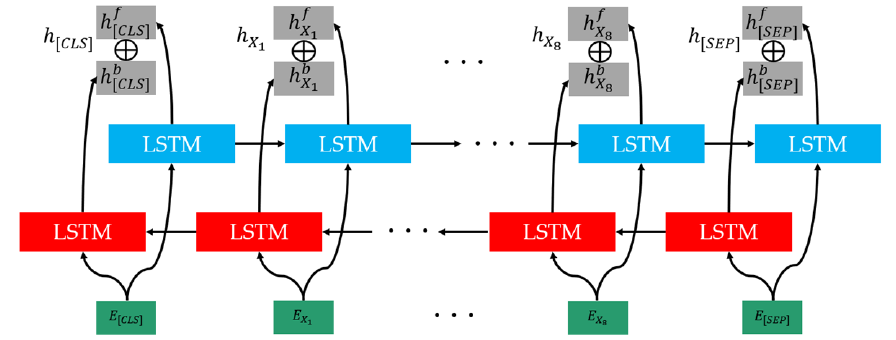
Figure 11. The framework of the shared layer.